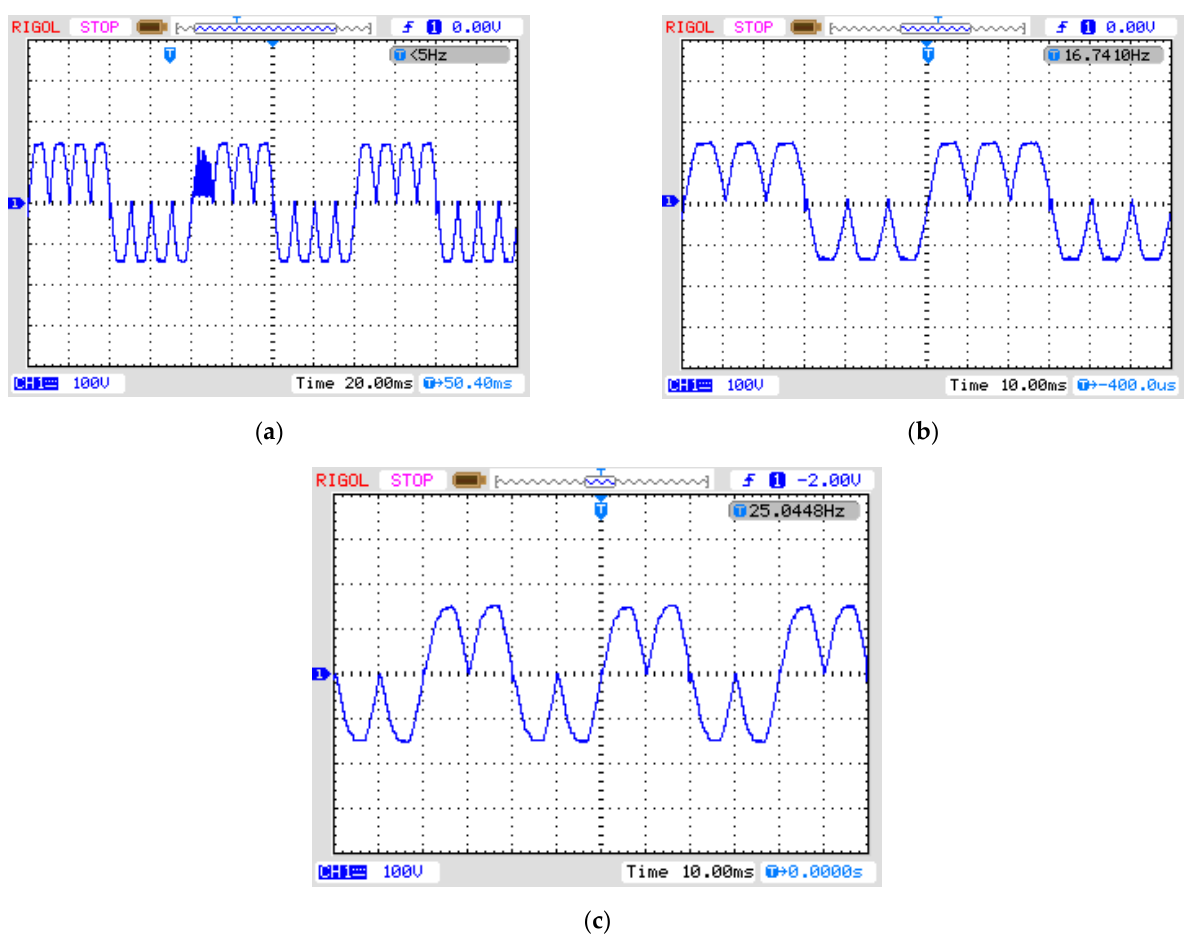
Figure 18. Stepping down of standard frequency (50 Hz) at the output to ( a ) 50/4 Hz; ( b ) 50/3 Hz; ( c ) 50/2 Hz.